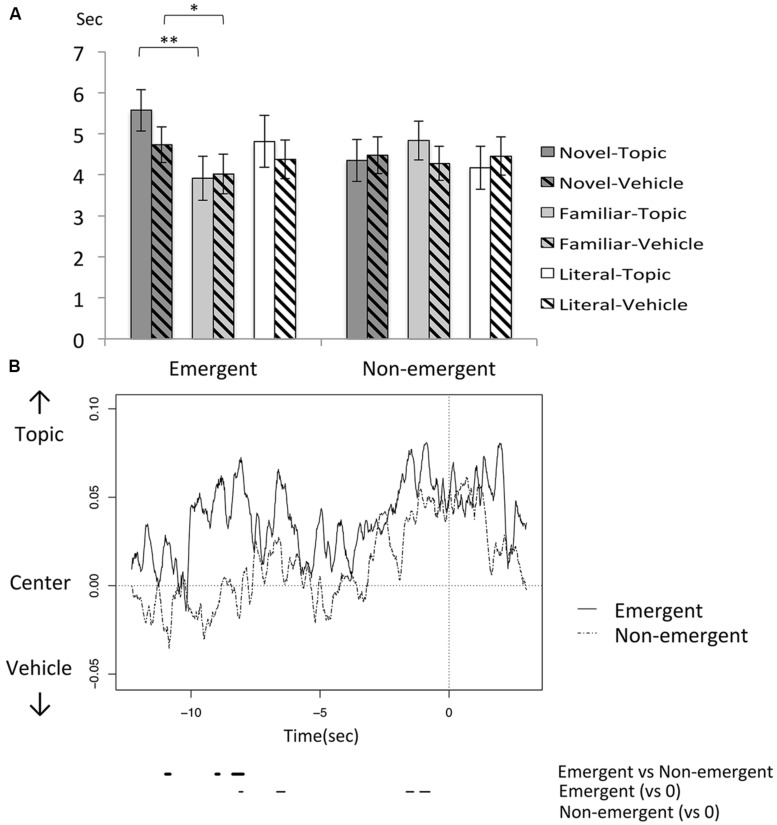
(A) Cumulative gaze durations (CGDs) to generate responses. Error bars represent SEM. ∗p < 0.05; ∗∗p < 0.01. (B) The time courses of x-axis gaze points within the N condition. The horizontal and vertical axes indicate time and normalized gaze points, respectively, and the time 0 indicates the onset of a spoken response. The solid lines (t < 0) below the time courses indicate the point when the gaze was shifted toward the topic and vehicle words and where the difference in gaze points (E vs. NE) was significant (p < 0.05).